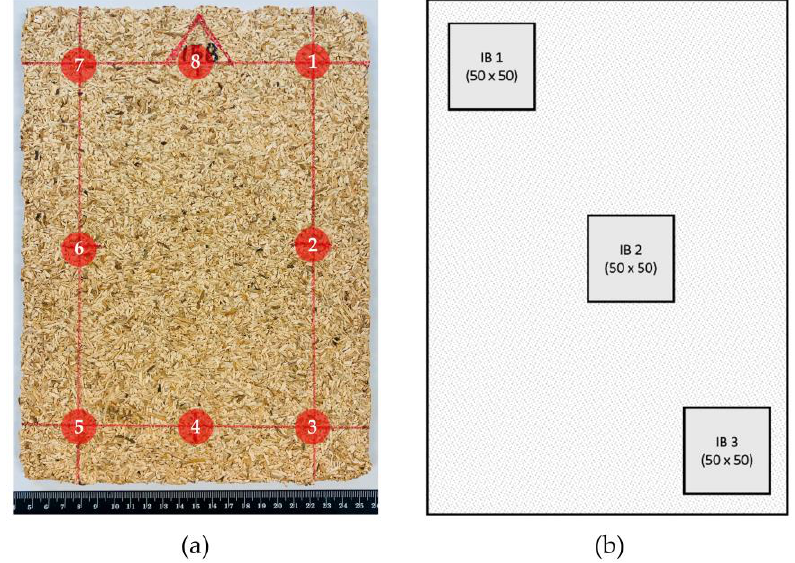
Figure 4. Measurement locations of panel thickness (positions 1 to 8 indicated) ( a ) and schematic IB specimen sampling per panel ( b ).